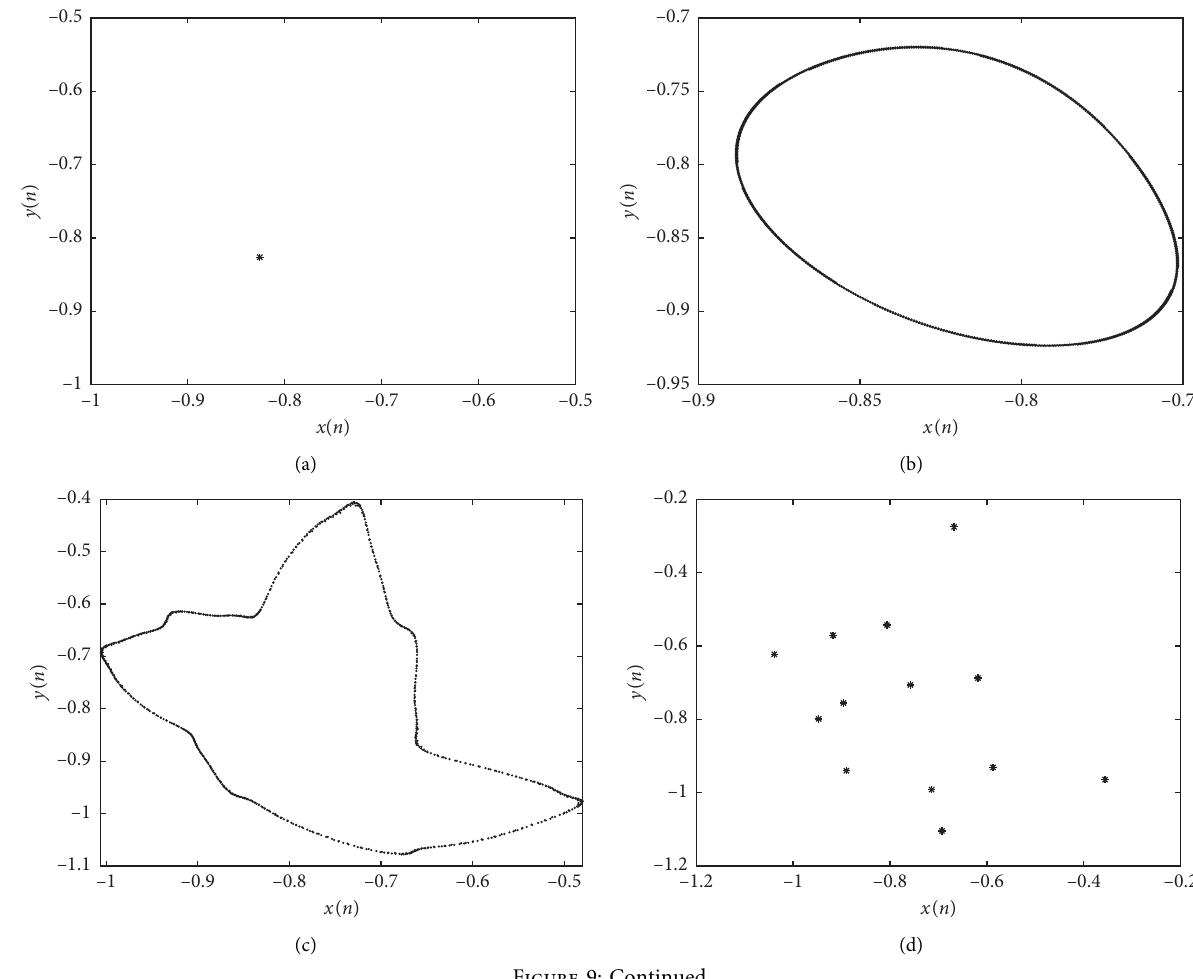
, (c) the LLE spectrum with x , and (d) the LLE spectrum with x 02 01